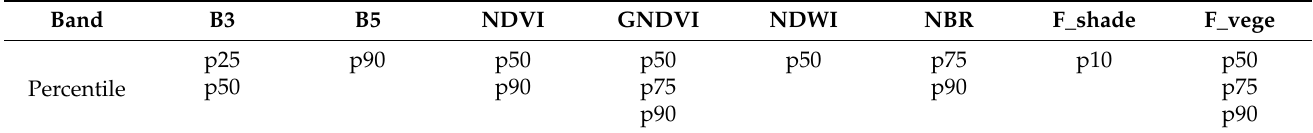
Table 2. Percentiles of each band used in the